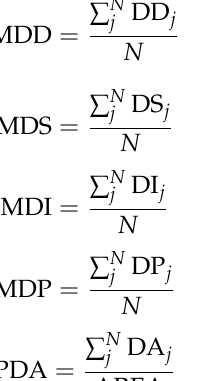
Figure 2. Definition of a drought event based on the Run Theory. In order to study the spatial and temporal characteristics of droughts at the grid scale, the drought characteristics are calculated in each grid, including mean drought duration (MDD), mean drought severity (MDS), mean drought intensity (MDI), and mean peak value (MDP). The percentage of drought area (PDA) represents the percentage of drought area in a region during a drought event. PDA is crucial to the study of drought characteristics, especially if different degrees of drought occur in different